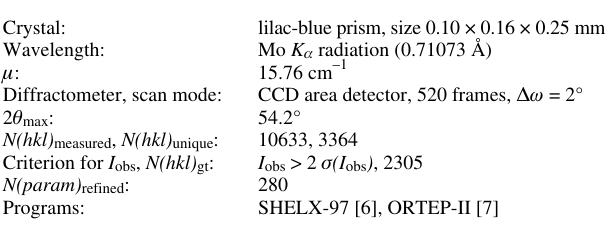
Table 1. Data collection and handling.